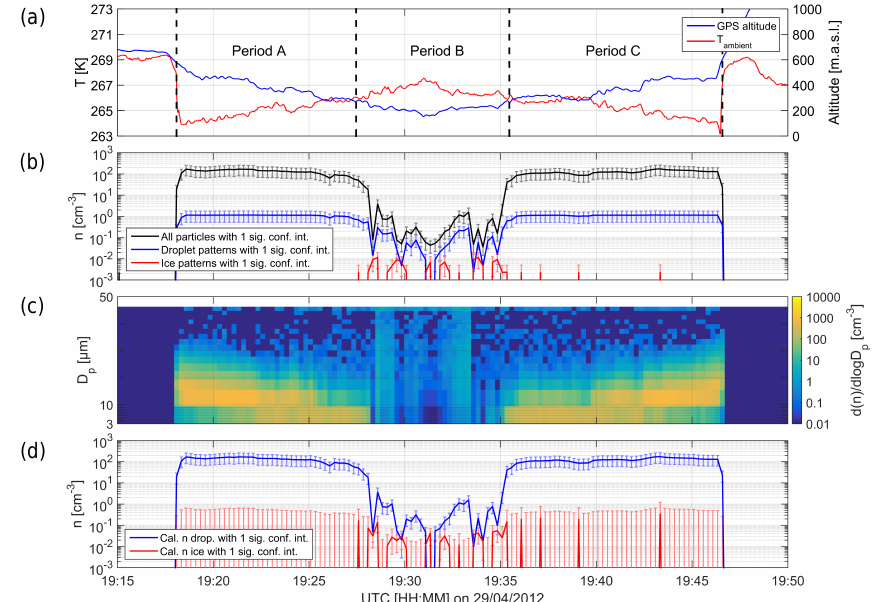
Figure 17. SID-3 measurements, with t av = 15s, from VERDI flight 7. In (a) the ambient temperature and altitude of the aircraft are dis- played. Periods A and C mark a step-wise descent and ascent of the aircraft. During period B the altitude was relatively constant. (b) displays the particle and pattern number concentrations recorded by the SID-3. (c) shows the particle number size distribution. In (d) the calculated droplet and ice number concentrations are